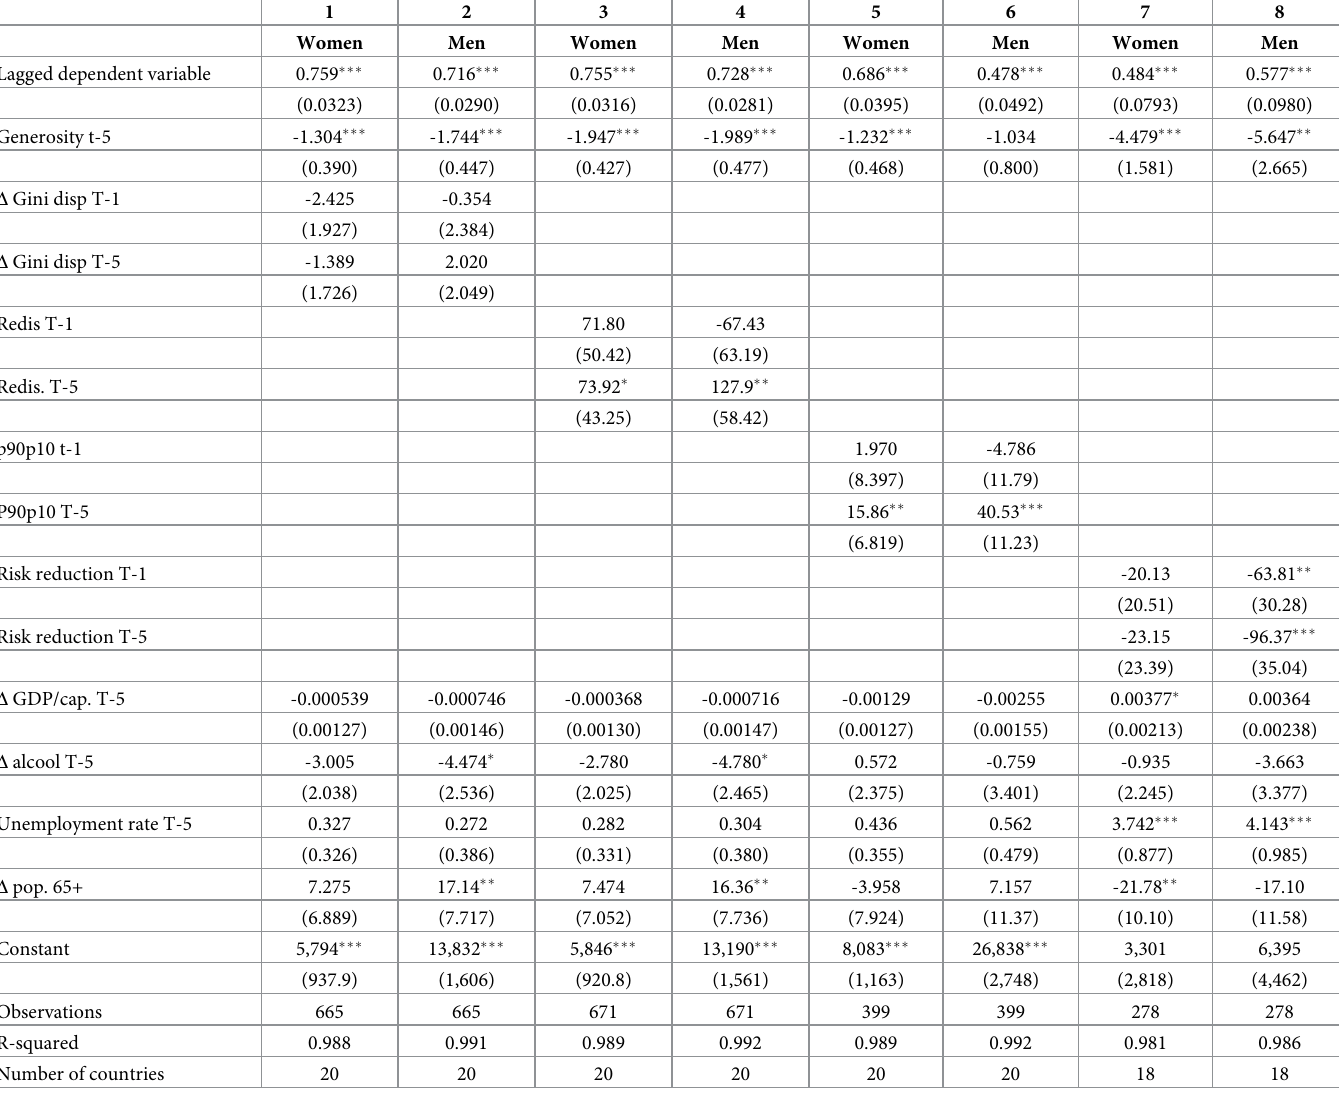
Table 3. Relationships between the generosity index and the age-standardized death rate, controlling for Gini, redistribution, p90p10, and risk reduction, and including fixed effects and country specific time